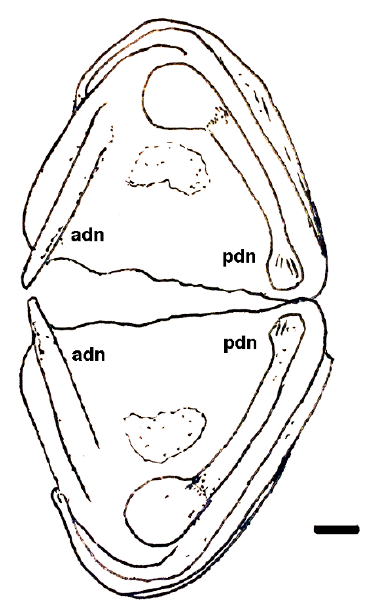
Figure 16. Hipponicharion skovstedi . Paired shields shown in butterfly position. Anterior to left. Scale bar 200 microns. Abbreviations: adn , anterodorsal node; pdn , posterodorsal node. Image Credit: Mark McMenamin.